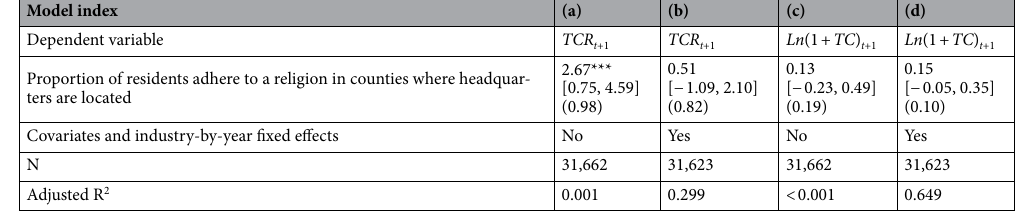
Table 2. The relationship between the degree of religious affiliation among residents in the county in which an enterprise’s headquarters is located and measures of workplace injury in its establishments. Columns (a) and (b) display statistics from models that regressed each private-sector establishment’s Total Case Rate of injuries, illnesses, and deaths (TCR)—as recorded by the United States Occupational Safety and Health Administration (OSHA) 40 from 2002 to 2011—on, respectively, its county’s proportion of residents acknowledging a religious adherence 30,33,34 (a) and that variable plus a set of covariates and industry-by-year fixed effects (b). Columns (c) and (d) report regressions of the natural logarithm of one plus Total Cases of injuries, illnesses, and deaths (TC) 40 on those same variables. All coefficient estimates and associated statistics appear in the supplementary information, but we display the estimate for the focal coefficient—proportion of population adhere to a religion in the county where an enterprise’s headquarter is located—in the third row of the table, following the model index and the listing of the dependent variable used in each model. The fourth row indicates whether the model involved covariates and binary indicators signaling the industry-year of a given record for an establishment. The second to last row lists the number of observations (N) and the final row displays the proportion of explained variance (R 2 ), adjusted for covariates. Asterisks denote the level of p values: *** p < 0.01, ** p < 0.05, * p <